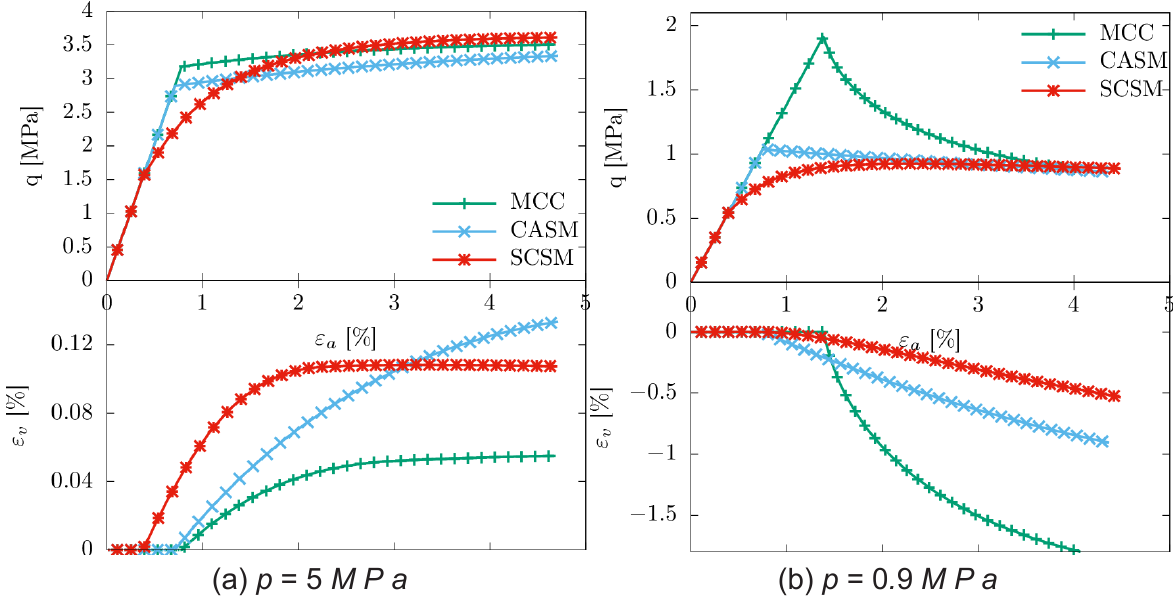
Figure 8: Simulation of pure triaxial shearing at constant effective pressure p